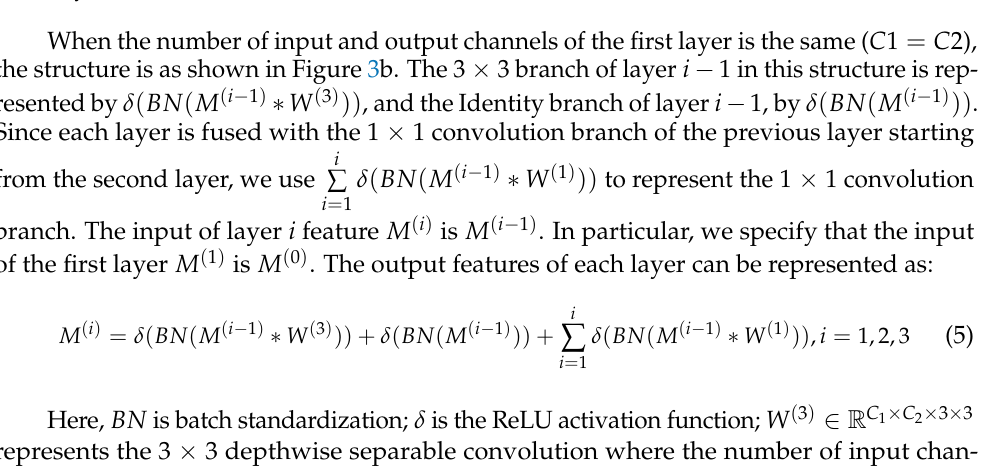
Figure 3. Optimizing time and space complexity structures. ( a ) Basic structure diagrams for optimizing time and space complexity. ( b ) A structure diagram with the same number of input and output channels in the first layer of the branch, ( c ) A structure diagram with a different number of input and output channels in the first layer of the branch (each convolution layer is followed by BN and ReLU layers) .